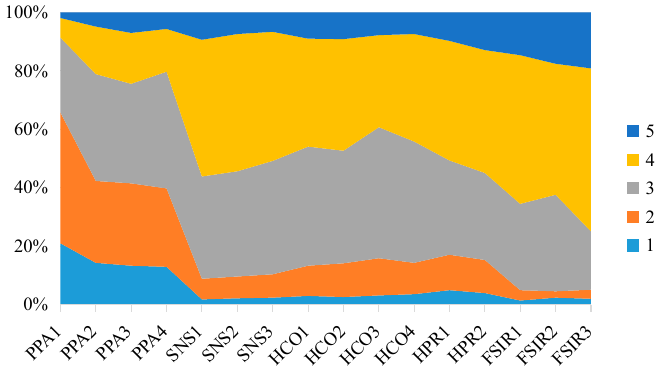
Figure 5. Descriptive statistics of respondents’ responses to survey items.